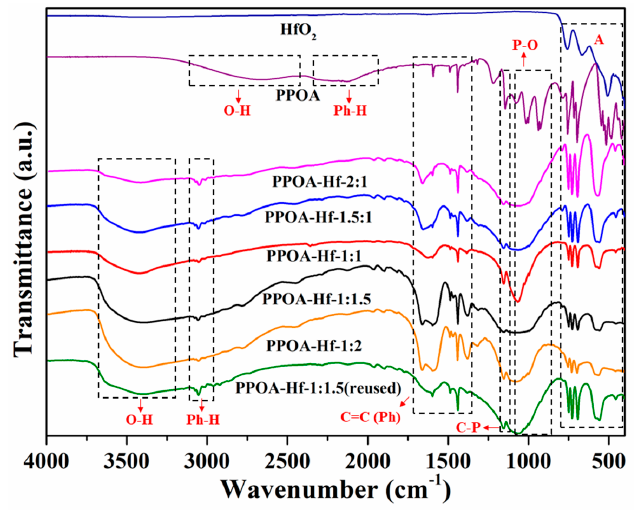
Figure 5. Fourier-transform infrared (FT-IR) spectra of PPOA–Hf– x with various PPOA/Hf molar ratios.